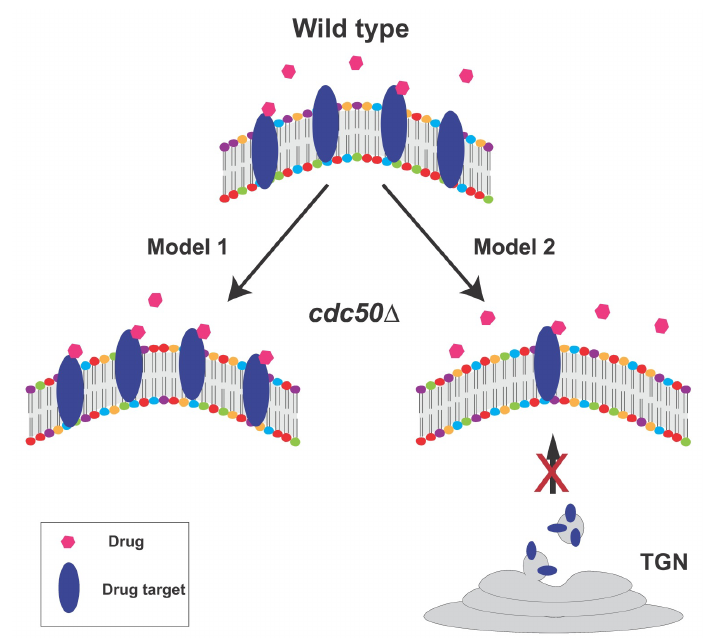
FIGURE 2: Two alternative, non-mutually exclusive working models of lipid flippase function in antifungal drug resistance. In Model 1, increased levels of PS (or other phospholipids) on the outer leaflet of the plasma membrane in the cdc50 ∆ mutant may change mem- brane structure in a way that promotes the interaction of certain drugs with their targets, thus enhancing drug-mediated inhibition of target activity. In Model 2, because lipid flippase activity is required for normal in- tracellular vesicle trafficking, vesicles containing specif- ic drug targets may be incorrectly targeted, reducing correct drug target localization, impairing these path- ways, and increasing sensitivity to the corresponding antifungal drugs. TGN: trans-Golgi